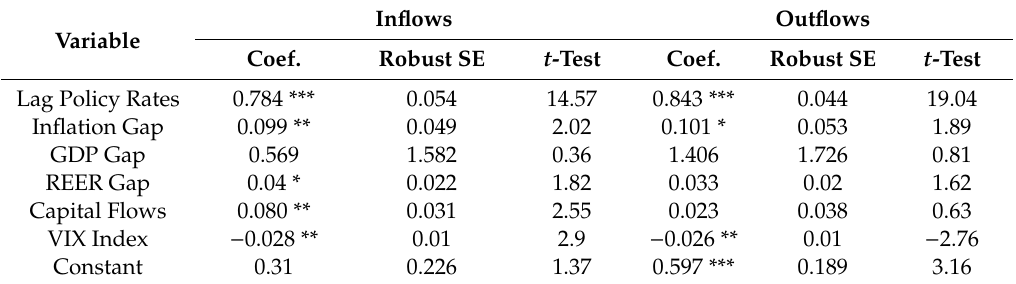
Table 7. The Augmented Taylor Rule with Capital Inflows and Outflows Using the US